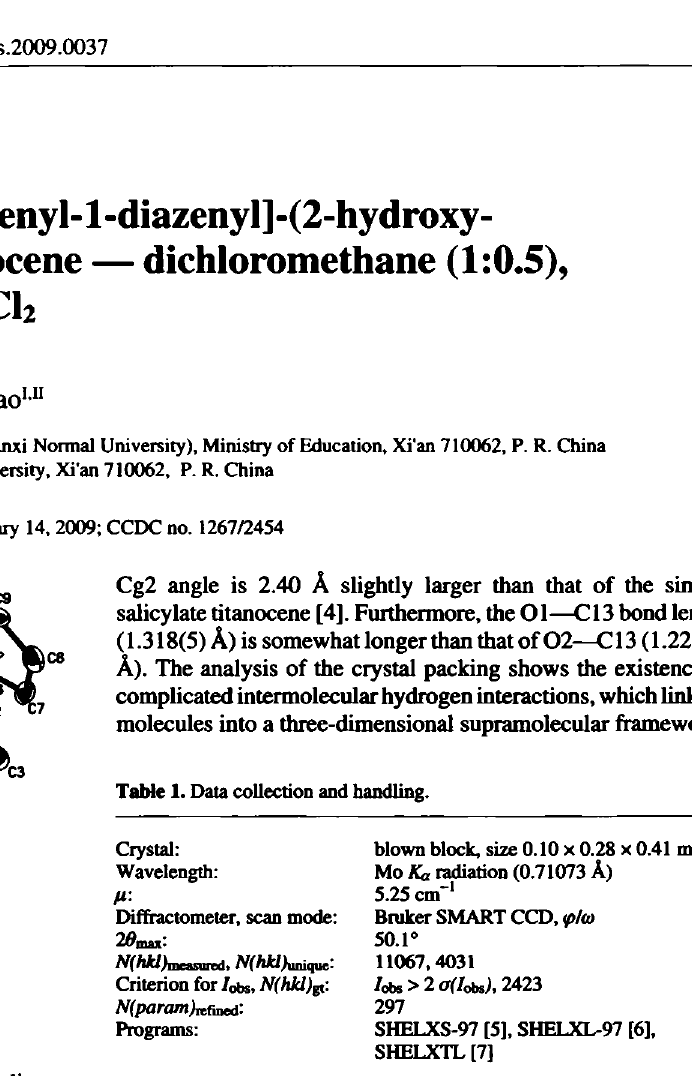
Table 2. Atomic coordinates and displacement parameters (in Â 2